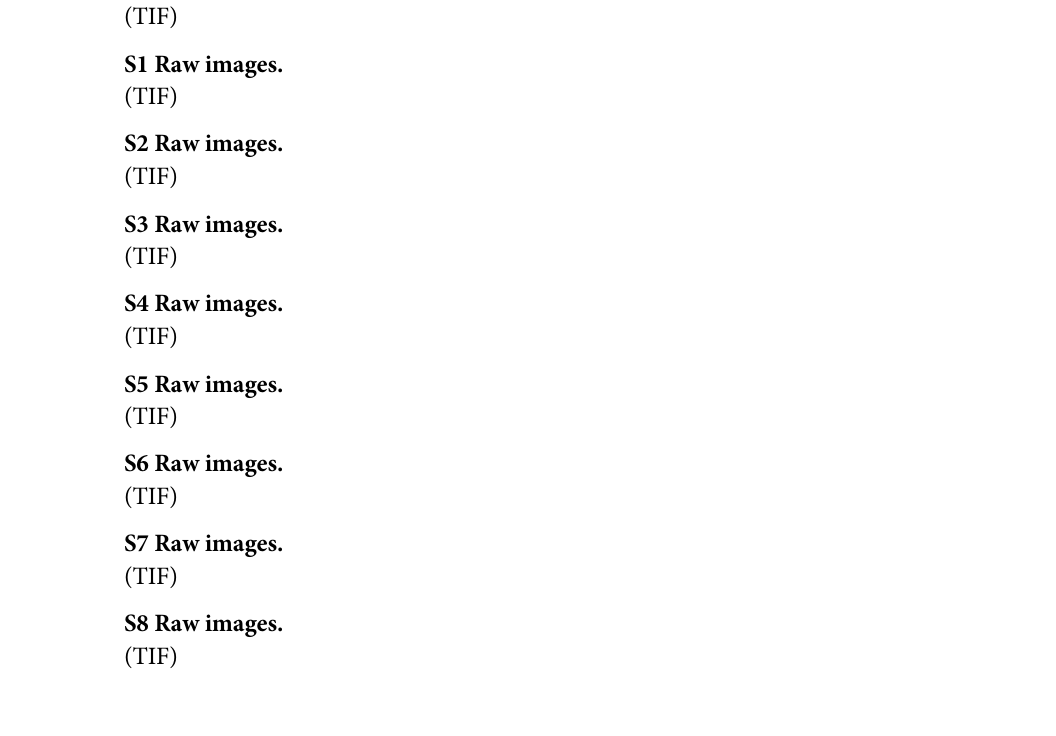
predicted transcript devoid of the PYD is highlighted with a red arrow. S4 Fig. Specificity of a few anti-NLRP6 commercial antibodies. (A) Schematic representation of the structure of the NLRP6 protein with the position of the epitopes against which the antibodies used in B are directed. (B) Western-blot analysis of extracts of HCT116 cells transiently transfected by the empty or FLAG-NLRP6-expressing pCDNA3.1+ vectors and of non-transfected RKO cells with antibodies from Abiocode and ABGENT. NLRP6 is indicated with a dark arrowhead. The white arrowhead points the non-specific doublet at 90kDa. The red star underlines another non-spe- cific band migrating very close to NLRP6. (C) Western-blot analysis with antibodies from Millipore and ABclonal of extracts of non-transfected HPCEC cells, non-transfected RKO cells and HCT116 cells transiently transfected by the FLAG-NLRP6-expressing pCDNA3.1+ vectors and then trans- fected with siRNAs against NLRP6 or control siRNAs of non-transfected RKO cells. NLRP6 is indi- cated with a dark arrowhead. The white arrowhead points the non-specific doublet at 90kDa. (TIF) S5 Fig. The 90kDa protein is unsensitive to siRNAs directed against NLRP6. Western-blot analysis with the anti-NLRP6 antibody from ABGENT of extracts of HCT116 cells transiently transfected with the empty or the FLAG-NLRP6-expressing pCDNA3.1+ vector and further transfected with siRNAs against NLRP6. NLRP6 is indicated with a dark arrowhead. The white arrowhead points the non-specific doublet at 90kDa. S6 Fig. Preparation of samples for mass spectrometry analysis. Right: photograph of the SDS-PAGE gel in which gel fragments were collected and numbered for further Mass spec- trometry analysis. Left: image of a representative western-blot analysis using the anti-NLRP6 from ABGENT of the expression of NRLP6 and of the 90kDa protein in the extracts used for the Mass Spectrometry analysis. NLRP6 is indicated with a dark arrowhead. The white arrow- head points the non-specific doublet at